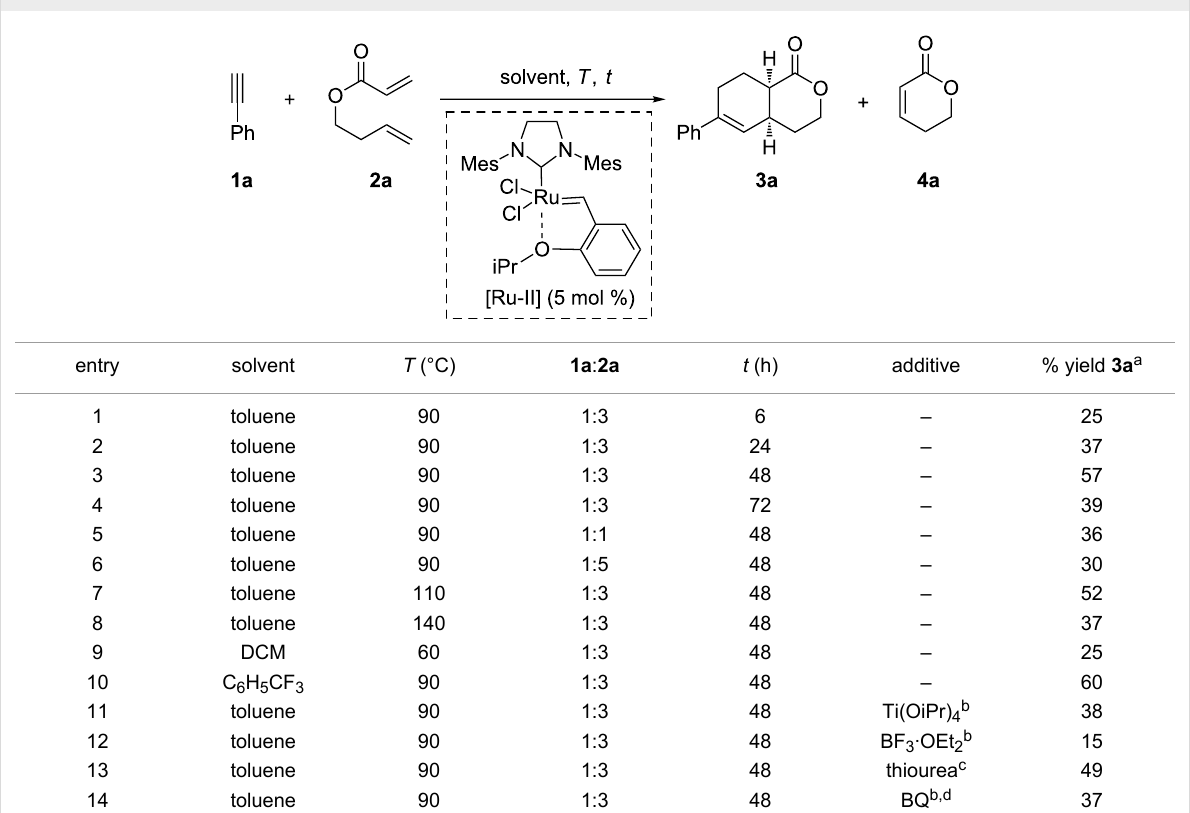
Table 1: Optimization of the tandem